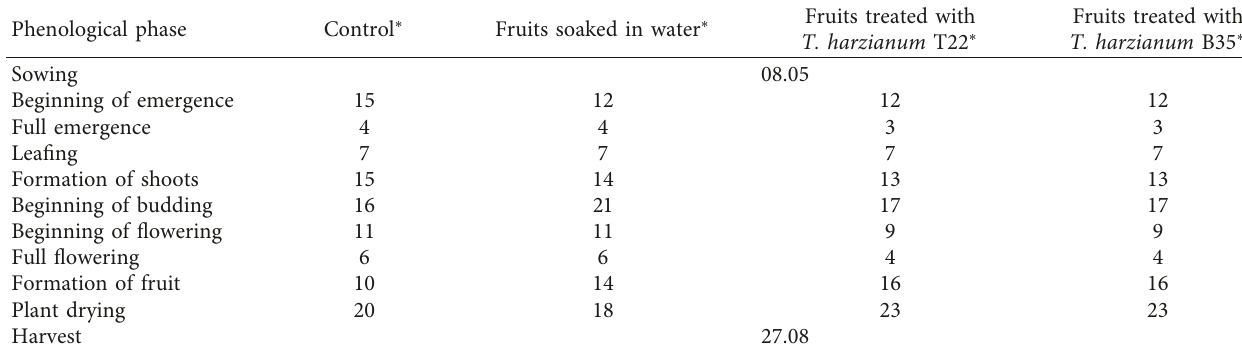
Table 2: Length of phenological phases of coriander in the growing season.